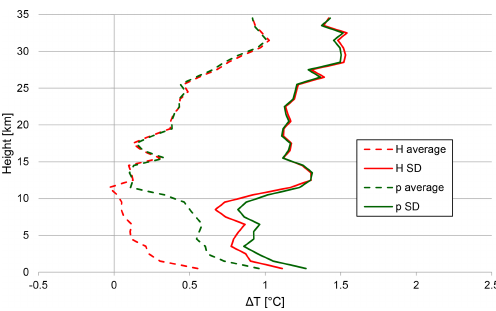
Figure 21. The temperature ( T ) bias and standard deviation (SD) when ascent and descent levels are matched using height (red) or pressure (green), averaged over 7 months of Praha-Libus profiles.